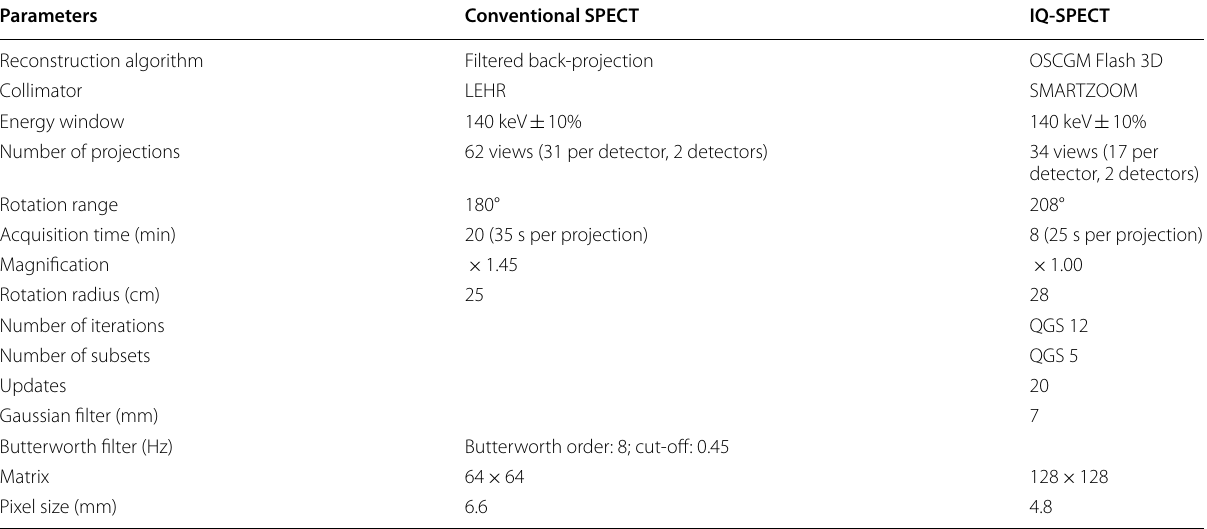
Table 1 Common SPECT acquisition and reconstruction parameters